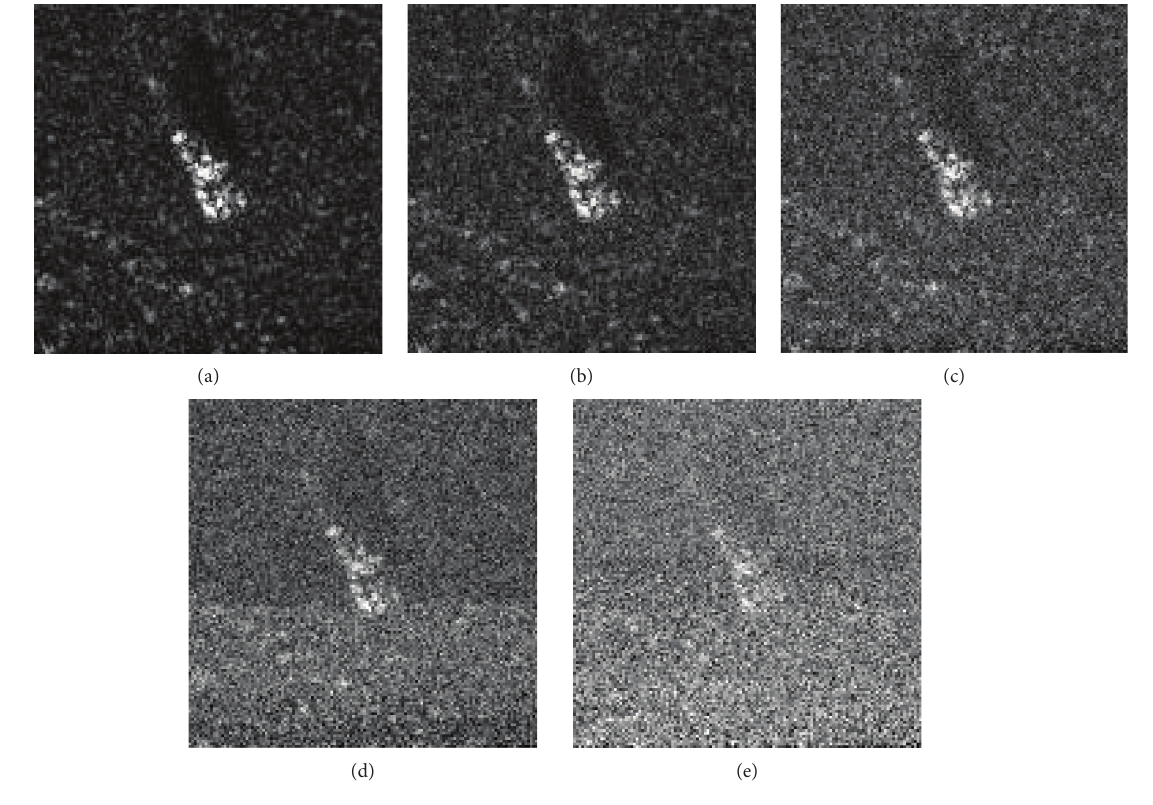
Figure 13: Image after adding different noises. Table 4: Confusion matrix of Enhanced-shape CNN.